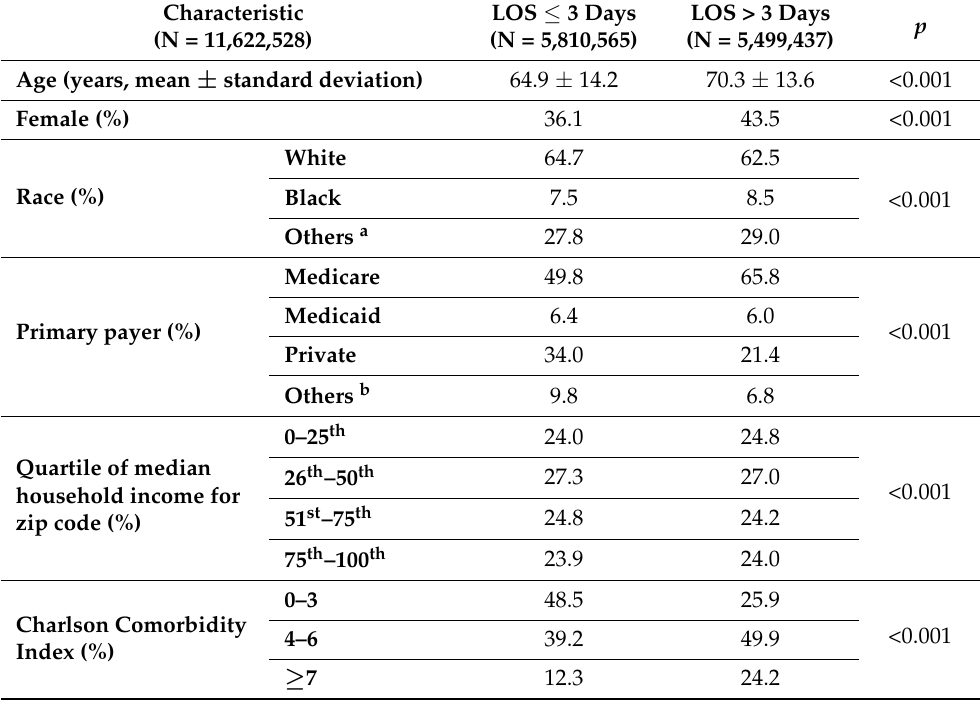
Table 1. Baseline characteristics of AMI admissions LOS ≤ 3 days and LOS > 3